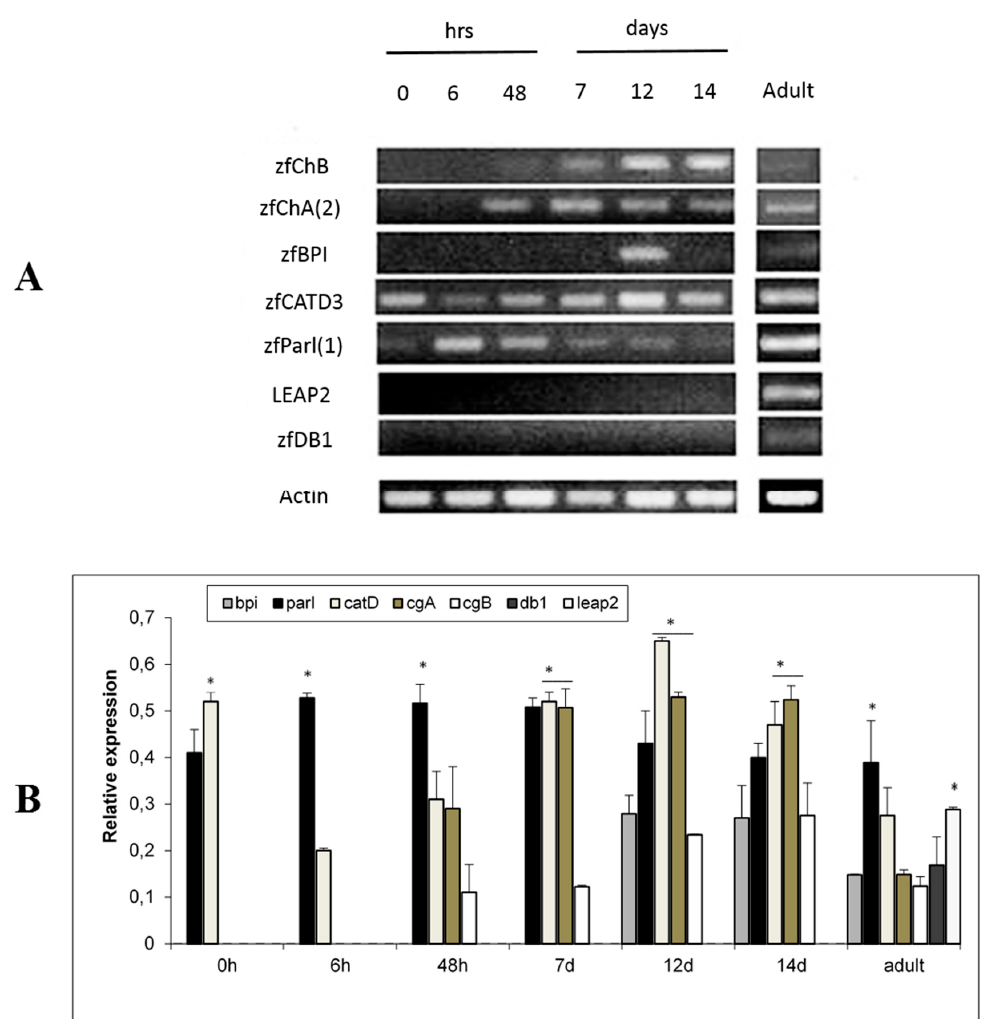
Figure 7. RT-PCR analysis of AMP expression during development (0, 6, 48 h and 7, 12 and 14 days) and in adult zebrafish. ( A ) the products separated on agarose gel by electrophoresis show expression of chromogranin A (cgA), chromogranin B (cgB), BPI (bpi), cathepsin D (catD), parasin I (ParI), db1 ( β -defensin), and liver-expressed antimicrobial peptide (LEAP2); ( B ) densitometric analysis performed with Totallab software (CLIQS 1D pro; http://totallab.com/). In abscissa: stages of development; hours (h) and days (d). In ordinate: relative expression of AMPs. Results were obtained from a mean of triplicate experiments. Standard deviations are indicated on top of the bars. (*) From 0 h to 14 d: statistically higher vs. other AMPs, p < 0.001; in adult stage: parI, statistically higher vs. other AMPs; LEAP2, statistically higher vs . PBI, CgA, CgB, DB1 (Student t -test, two tails).